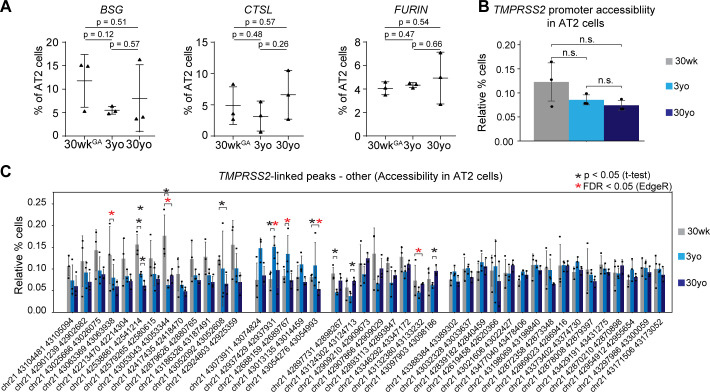
Gene expression of additional SARS-COV-2 cell entry genes and chrmatin accessibility of peak linked to TMPRSS2 during aging.(A) Fraction of AT2 cells with expression of BSG, CTSL and FURIN in 30wkGA,3yo and 30yo human lung samples. All data are represented as mean ± SD. (B) Promoter accessibility of TMPRSS2 in AT2 cells in 30wkGA, 3yo, and 30yo human lung samples. (C) Fraction of cells with accessibility at peaks co-accessible with TMPRSS2, which did not show increase with age. Data are represented as mean ± SD. Red asterisks denote FDR < 0.05 (EdgeR) and black asterisks denote p<0.05 via independent t-test.